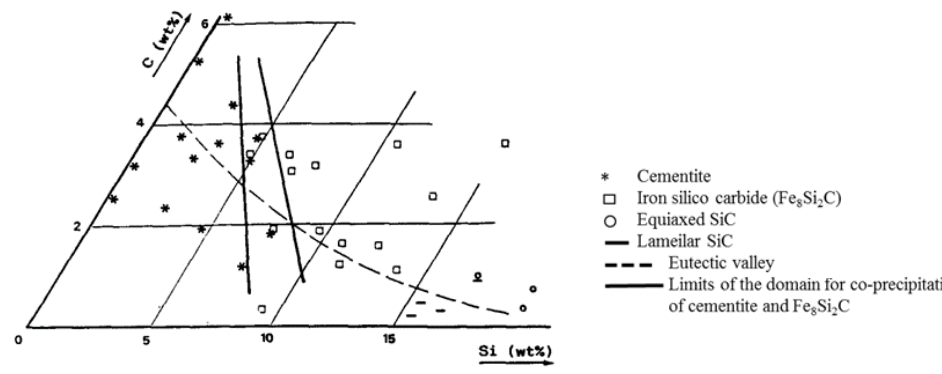
Figure 11. Variation with composition of the nature of the carbide phase observed from rapidly cooled samples from the liquid state (from [35]).